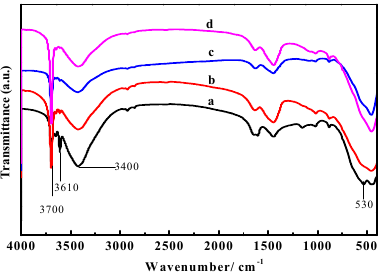
Figure 14. FT-IR spectra of the surface layer of the MOC samples after different dry–wet cycles: (a) without dry–wet cycles; (b) one time; (c) two times; (d) three times.